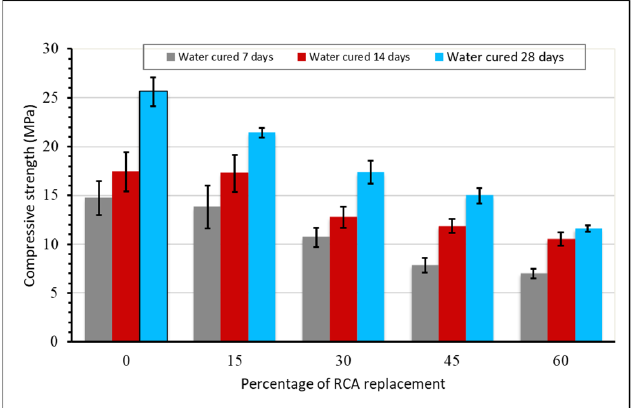
Figure 5. Compressive strength results for all mixtures, error bars represent the calculated standard deviations for the experimental data.